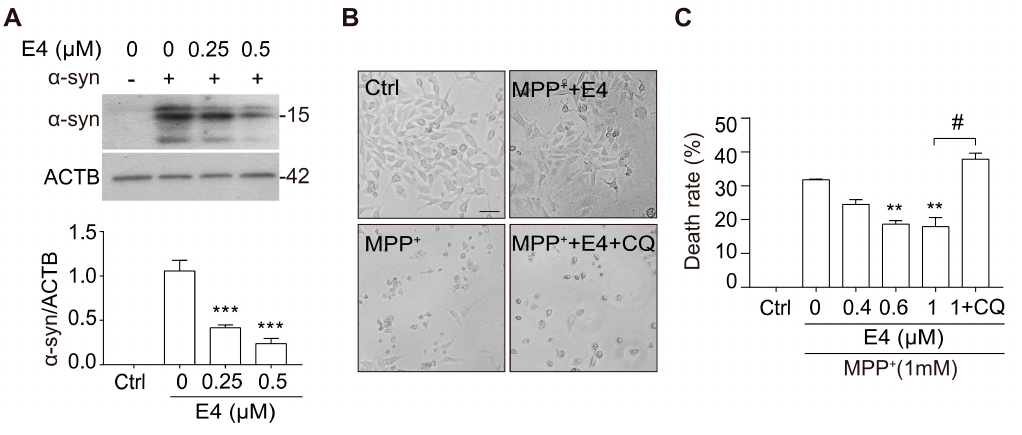
Figure 5. Compound E4 reduces α -syn levels and protects against MPP + toxicity in vitro. ( A ) N2a cells were transfected with A53T α -syn plasmid and then treated with E4 at indicated concentration. Data are presented as the mean ± SEM from 3 independent experiments. ( B ) Bright field of PC12 cells after incubation with E4 (1 µ M) present or absence of CQ (20 µ M) in MPP + (1 mM) treated cells. Scale bar: 50 µ m. ( C ) Cell viability of E4 present or absence of CQ against MPP + induced cell injury. Data are presented as the mean ± SEM from three independent experiments. * p < 0.05, ** p < 0.01, # p < 0.05, n.s. not significant.